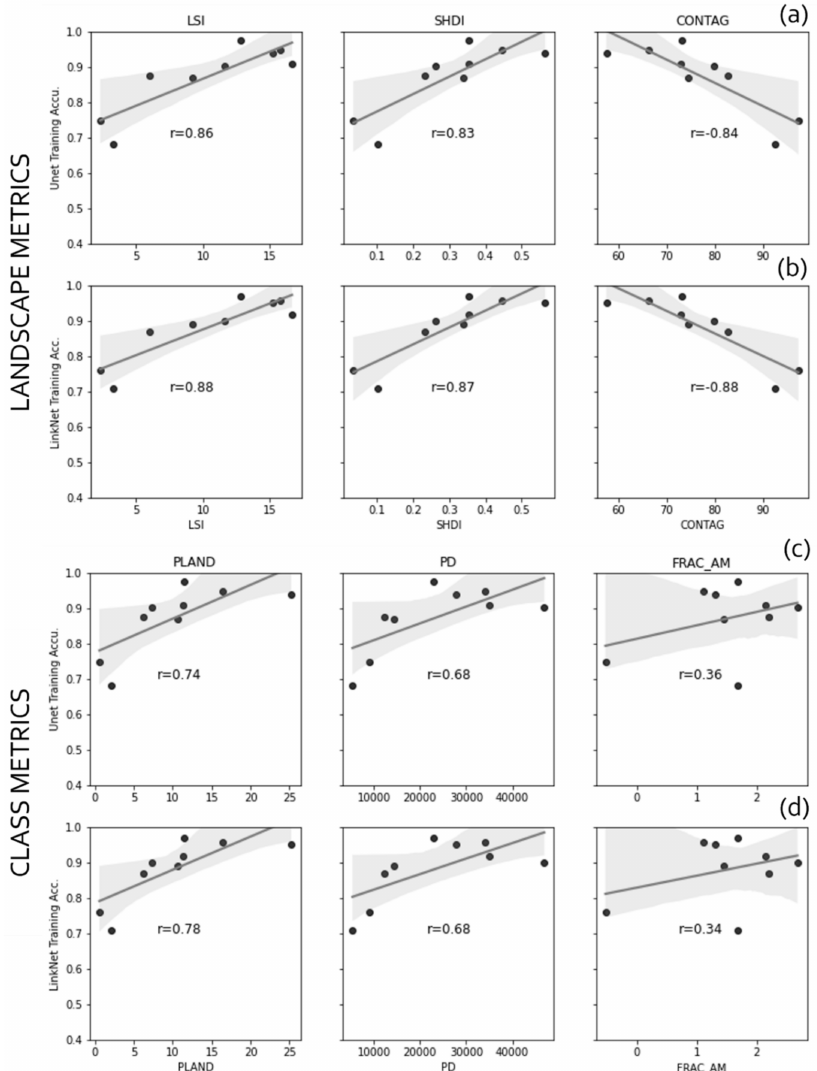
Figure 7. Scatterplot and Pearson’s correlation (r) showing the relationship between different types of landscape-level ( a , b ) and class-level ( c , d ) metrics and U-Net ( a , c ) and LinkNet ( b , d ) training accuracies. The grey line represents the regression line, and the shaded area represents the 95% confidence interval for that